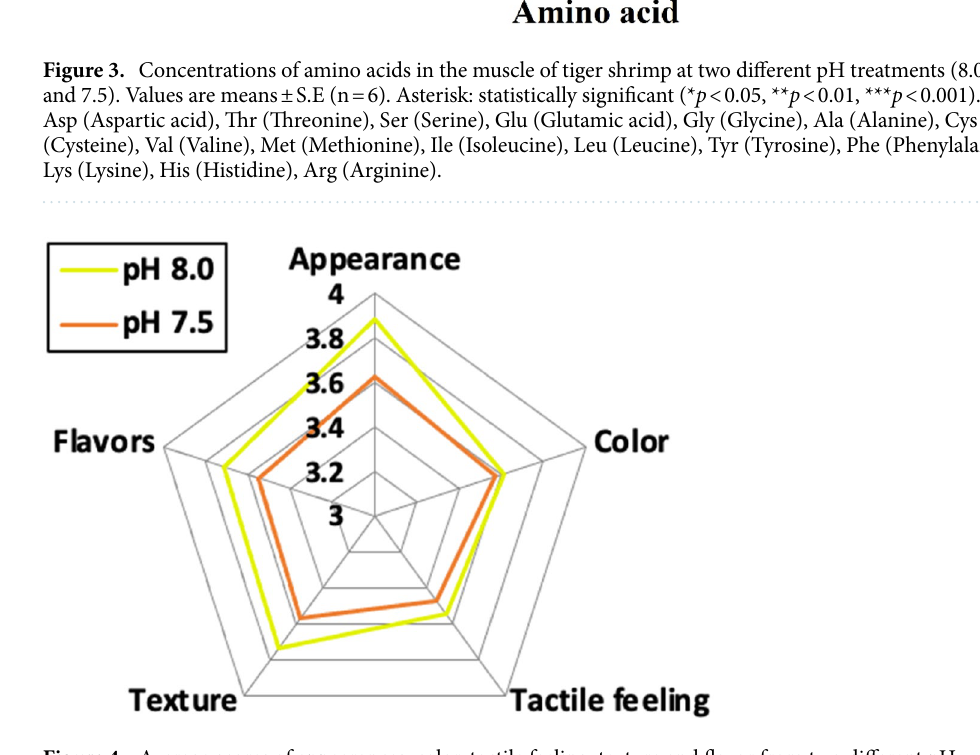
Figure 4. Average scores of appearances, color, tactile feeling, texture and flavor from two different pH treatments (8.0 and